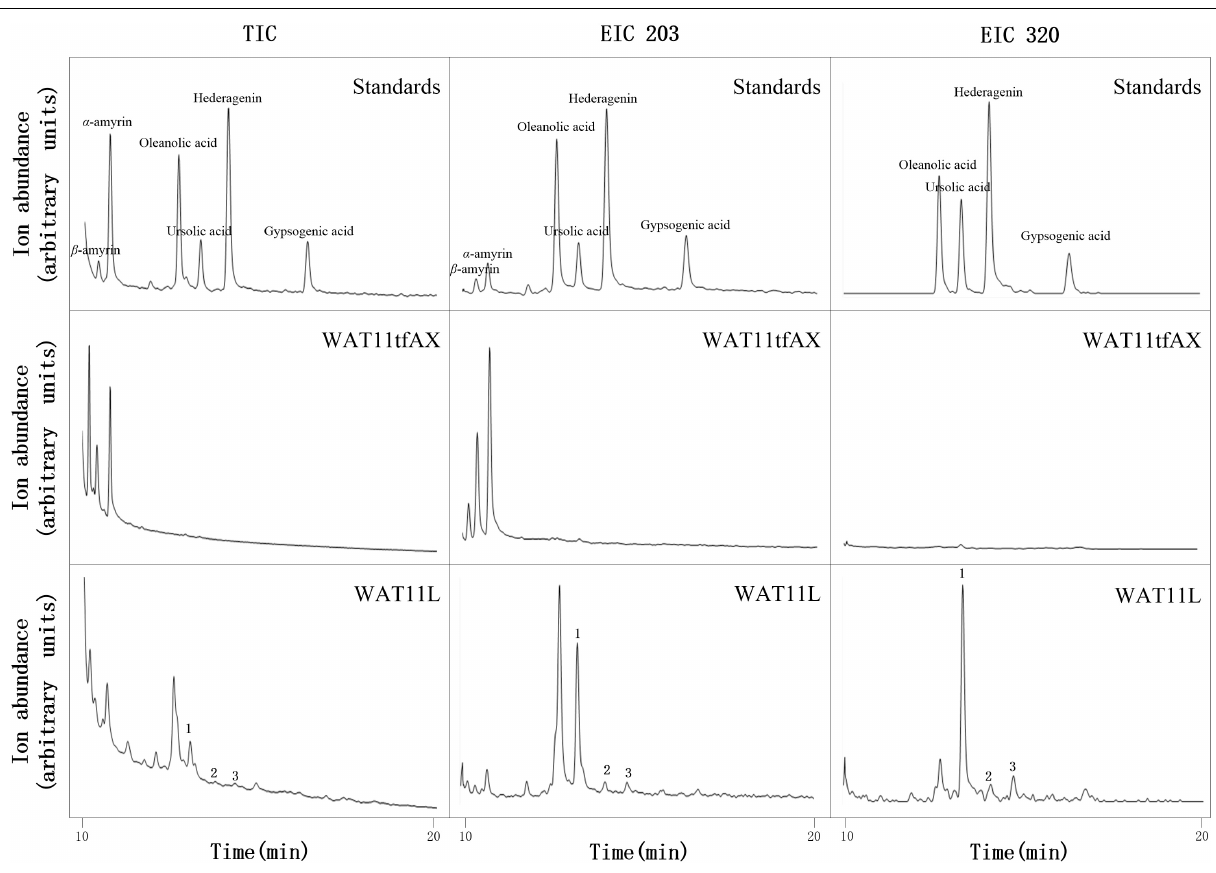
Frontiers in Plant Science |